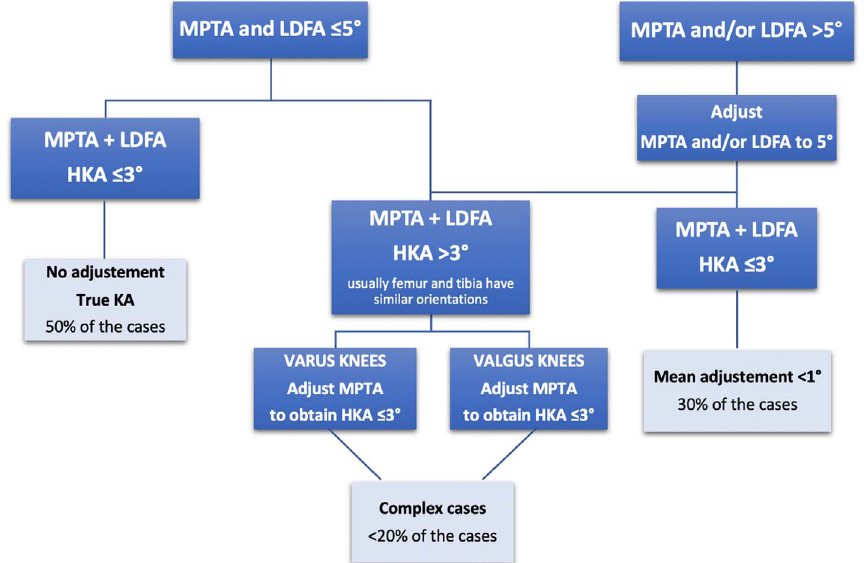
Figure 3. Restricted kinematic alignment